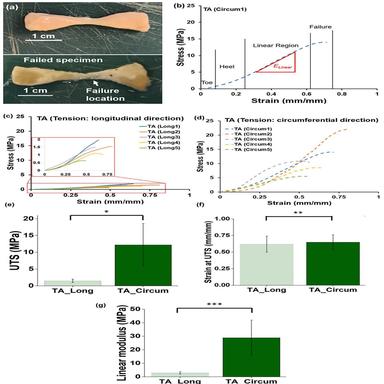
(a) TA specimen before and after failure – the latter shows some micro failures in the tissue, (b) The four characteristic stages that were observed during TA testing in tension. Uniaxial tensile testing of TA in the longitudinal (c) and circumferential (d) directions. The corresponding tissue properties (e) ultimate tensile stress (UTS) (independent t-test, ∗p ≤ 0.01), (f) strain at UTS (independent t-test, ∗∗not significant) and (g) linear modulus (independent t-test, ∗∗∗p ≤ 0.005).